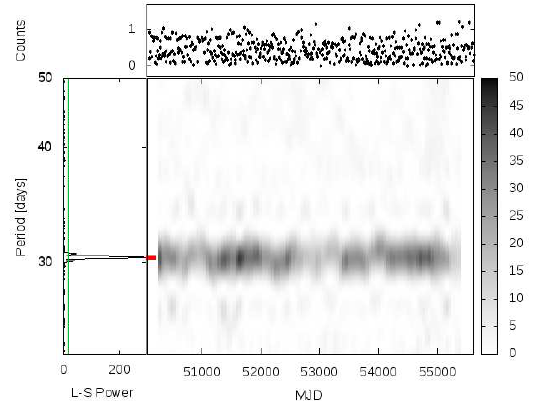
Figure 4: LMC X-4: The steady long-term period may be produced by a stable radiation-driven warp.